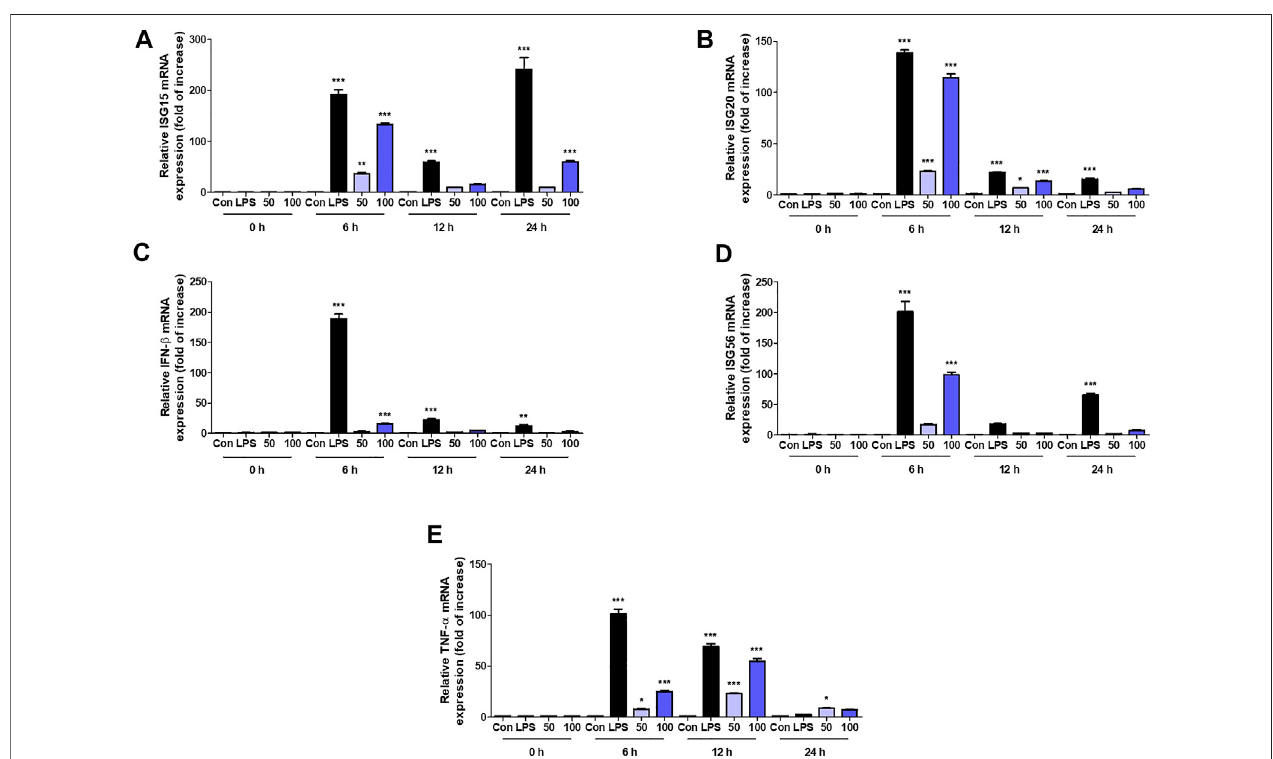
FIGURE 4 | Induction of transcription of the interferon (IFN)-related gene and IFN-stimulated genes (ISGs) by OCD20015-V009 in RAW 264.7 cells. The cells were treated with the vehicle alone (Con), 200 ng/ml lipopolysaccharides (LPS), or 50 or 100 μ g/ml OCD20015-V009 and then incubated at 37 ° C with 5% CO 2 . The time- dependentchangesinthemRNAlevelsofISG-15, 20,and 56,TNF- α ,and IFN- β genes (A – E) inRAW264.7cellsafter OCD20015-V009treatmentwereexamined. The data are representative of three independent experiments. ** p < 0.01 and *** p < 0.001 indicates a signi fi cant difference between control groups.